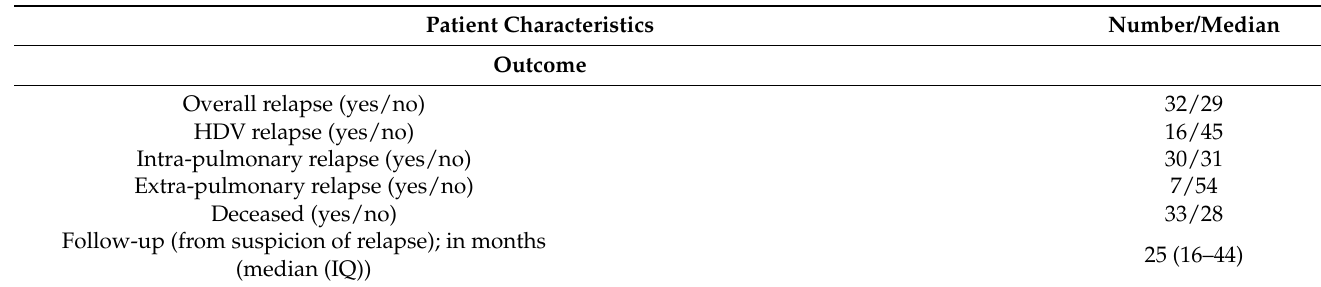
Figure 2. Patient with radiation-induced changes in HDV. ( a ) HDV defined as volume irradiated with >50% of max from the radiotherapy plan. The patient received SBRT (22 Gy × 3) for a T1N0M0 tumor in the right lower lobe. ( b ) FDG-PET/CT and ( c ) FLT-PET/CT 13 months after the end of radiotherapy showed only a faint shadow of FDG- and FLT-uptake in the